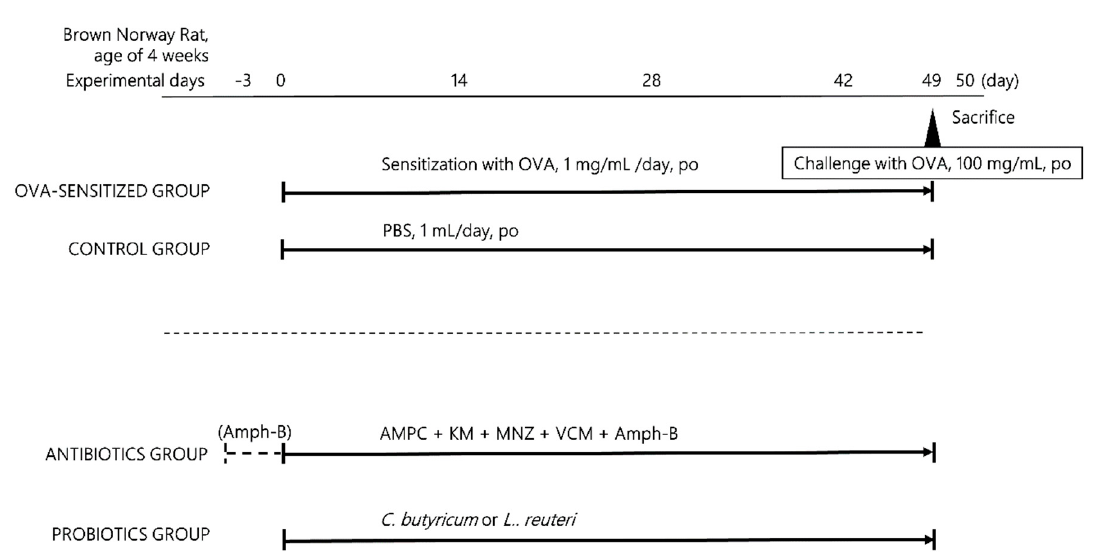
Figure 1. Protocol used for ovalbumin (OVA) sensitization, antibiotic or probiotic treatment, or challenge. Brown Norway rats in the control (PBS only) group were sensitized with PBS (1 mL per rat, daily) intragastrically for 48 days: in the OVA-treated group, rats were sensitized with OVA (1 mg in 1 mL PBS, daily per rat) intragastrically for 48 days. Both groups were subdivided into those receiving added antibiotics (amphotericin-B, ampicillin, kanamycin, metronidazole, and vancomycin) or probiotics ( Clostridium butyricum and Lactobacillus reuteri ). All OVA-sensitized rats received challenges on day 49 with 100 mg / mL OVA (in PBS 1 mL), and all rats in those groups were sacrificed and blood was collected on day 50 for further study. AMPC; ampicillin, Amph-B; amphotericin-B, KM; kanamycin, MNZ; metronidazole, OVA; ovalbumin, VCM;